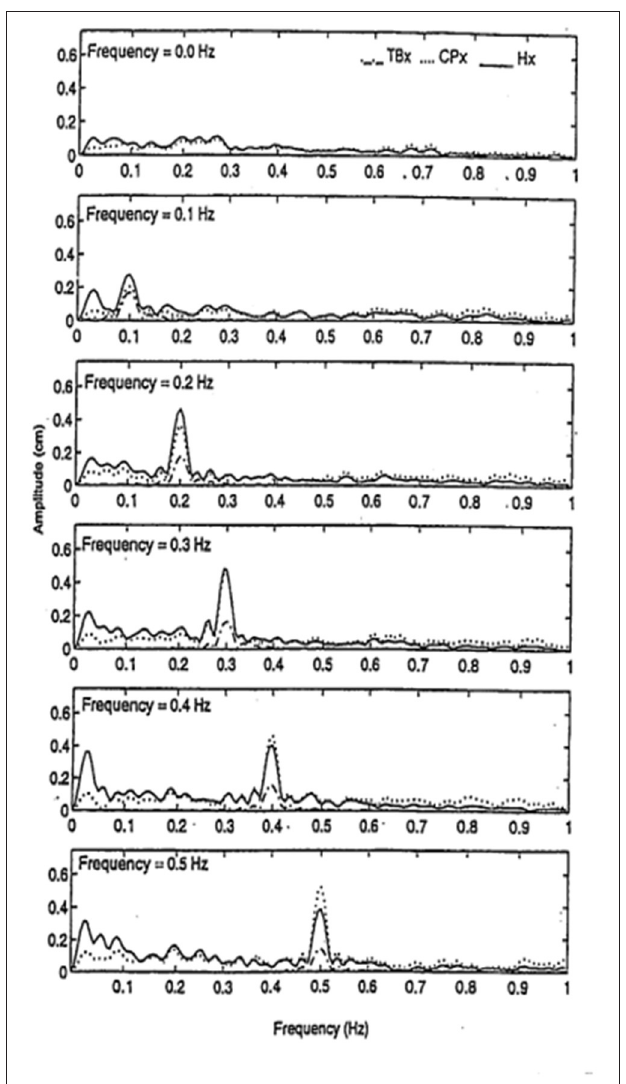
FIGURE 7 | Entrainment of body sway to cyclical lateral oscillations of the touch bar at frequencies of 0, 0.1, 0.2, 0.3, 0.4, and 0.5Hz. TB x = lateral motion ( ≈ 4mm amplitude) of touch bar, CP x = lateral motion of the center of pressure, and H x = lateral head motion. Subjects ( n = 5) show entrainment of head and center of pressure to the touch bar frequency of oscillation.